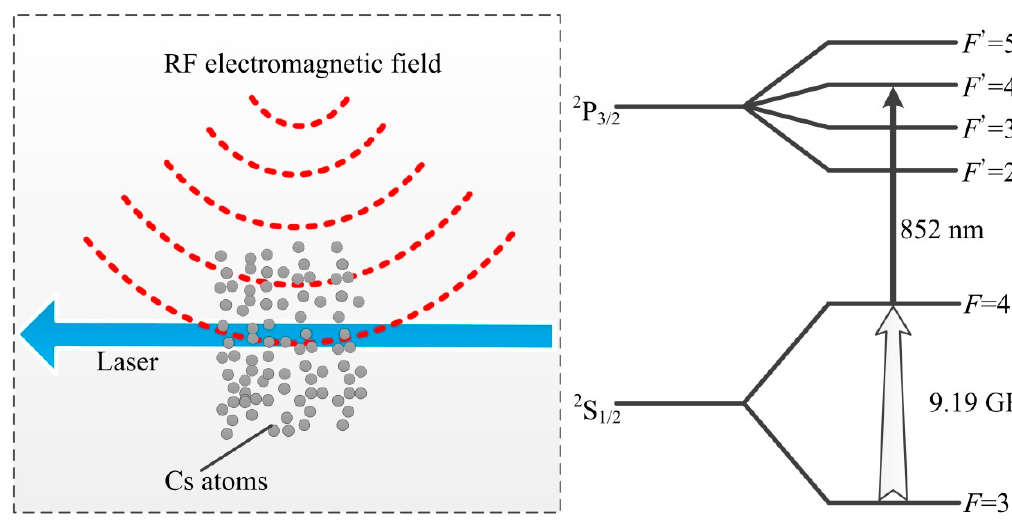
Figure 1. The left side is diagram of the interaction between laser and Cs atoms when the RF electromagnetic field is present. And the right side is diagram of energy level transition made in the interaction.